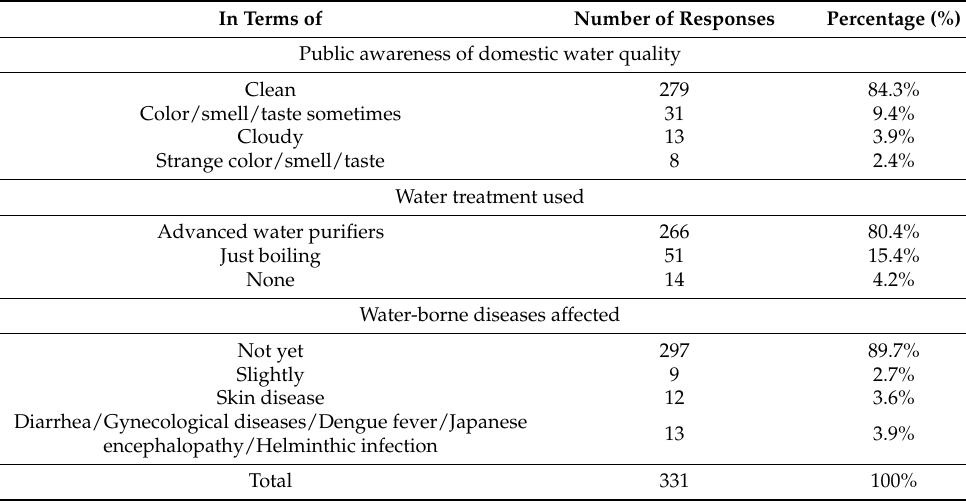
Table 4. Household responses regarding domestic water